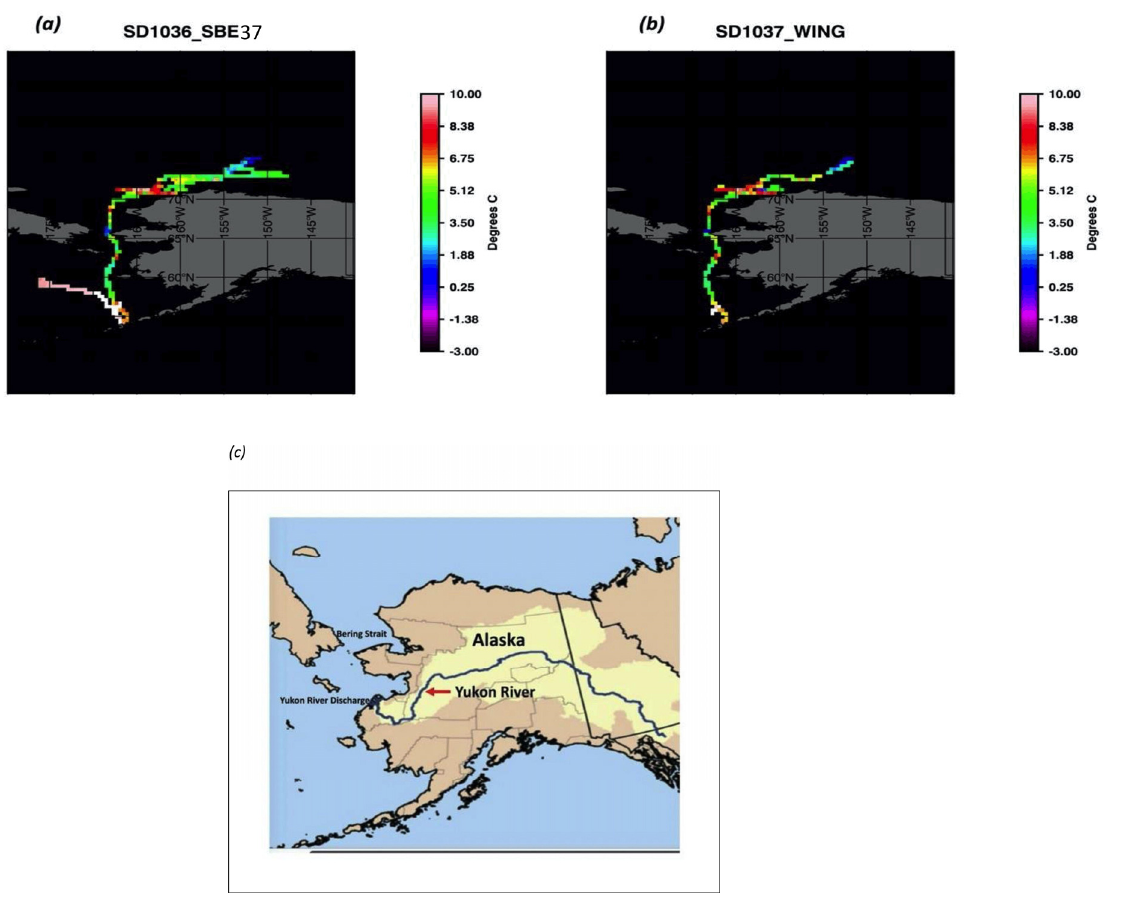
Figure 1. SST, derived from SBE37, along with the saildrone track for SD1036 ( a ) and SD1037 ( b ). The location of Y–K delta and rivers are shown in ( c ). location of Y–K delta and rivers are shown in ( c